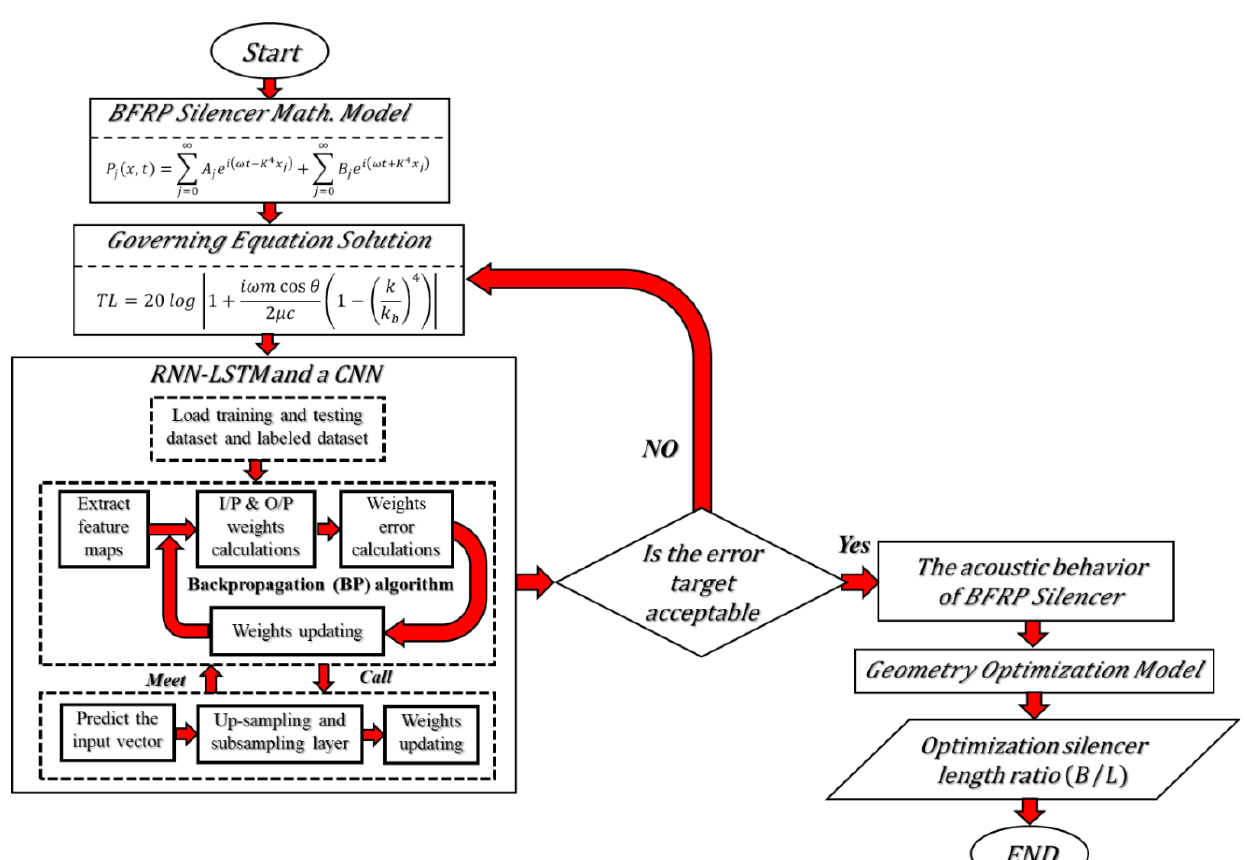
Figure 2. Flowchart of the proposed method.